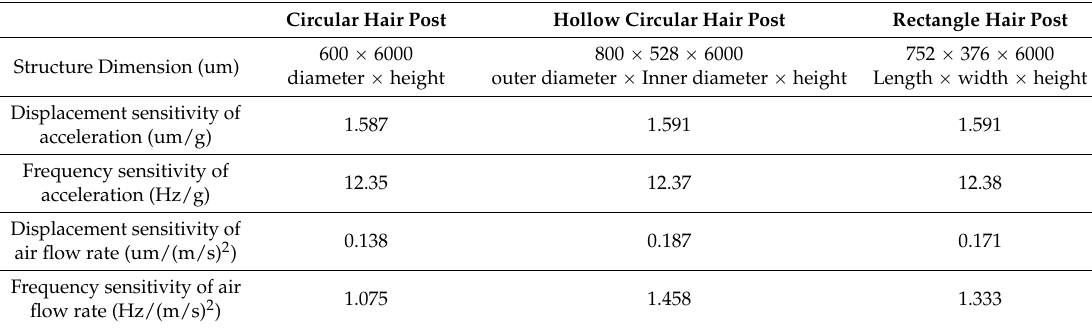
Table 5. Performance comparison of two kinds of hair structure.